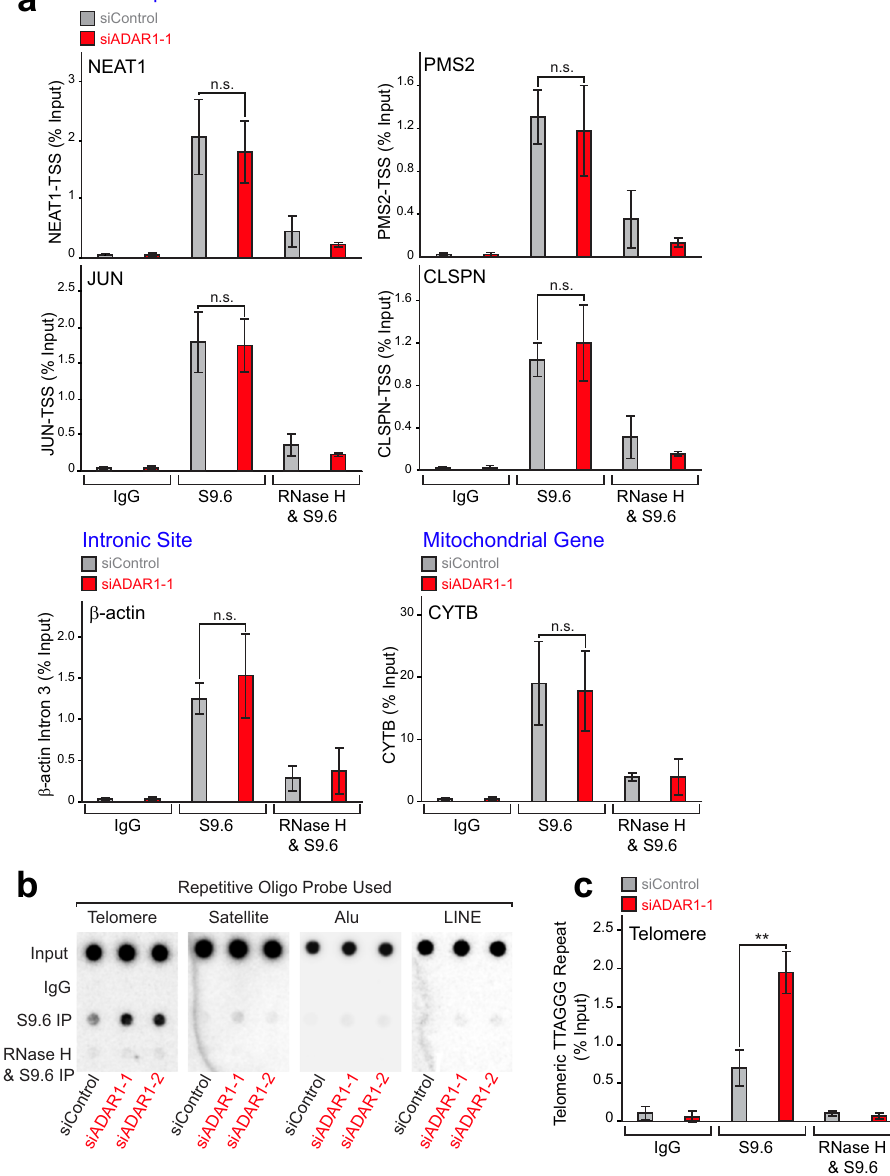
Fig. 3 Accumulation of R-loops at telomeres in ADAR1-depleted cells. a ADAR1 depletion had no effects on already known sites prone to the formation of R-loops. Six sites were examined by qPCR analysis of DRIP products. PCR primers used are listed in Supplementary Data 1. Data are mean ± SD ( n = 3, biological replicates); signi fi cant differences were identi fi ed by two-tailed Student ’ s t tests: n.s., not signi fi cant. b DRIP products were subjected to genomic DNA dot blot hybridization analysis with a probe containing the G-rich-telomere canonical repeat (TTAGGG), or a probe for α -satellite repeat, Alu , or LINE1 consensus sequence (Supplementary Data 1). ADAR1 depletion resulted in increased the formation of RNA:DNA hybrids speci fi cally at telomeric repeats, which was abolished by E. coli -RNase H treatment prior to DRIP. c Signi fi cance of the increased R-loop formation at telomeric repeats was con fi rmed by conducting three independent dot blot hybridization analyses of DRIP products. Data are mean ± SD ( n = 3, biological replicates); signi fi cant differences were identi fi ed by two-tailed Student ’ s t tests: ** P < 0.01, n.s., not signi fi cant. a , c All individual experimental data values and exact P values are presented in Source Data fi